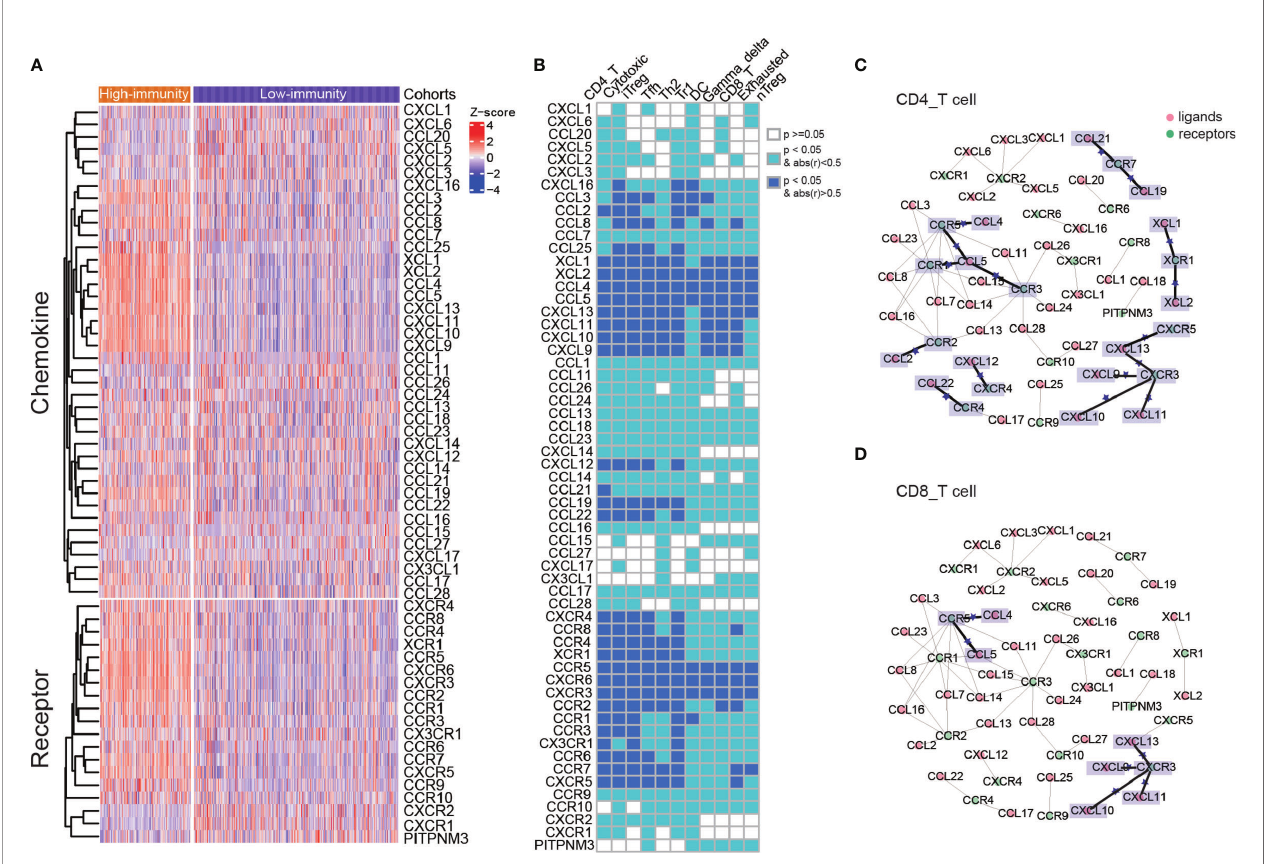
FIGURE 3 | Different expressions of chemokines and their receptors between two immunity cohorts, and the chemokine – receptor pairs in immune cells. (A) The differences in gene expressions of the chemokines and their receptors between the high-immunity and low-immunity cohort. (B) The correlations of chemokines and their receptors with immune cell in fi ltration. (C, D) Chemokine/receptor networks for immune in fi ltration of CD 4 T cells and CD 8 T cells. For a pair of interacting chemokine and receptor genes, if both were signi fi cantly correlated with immune cell in fi ltration, a star was placed on the edge connecting the chemokine and receptor. Statistical signi fi cance was calculated using Spearman ’ s